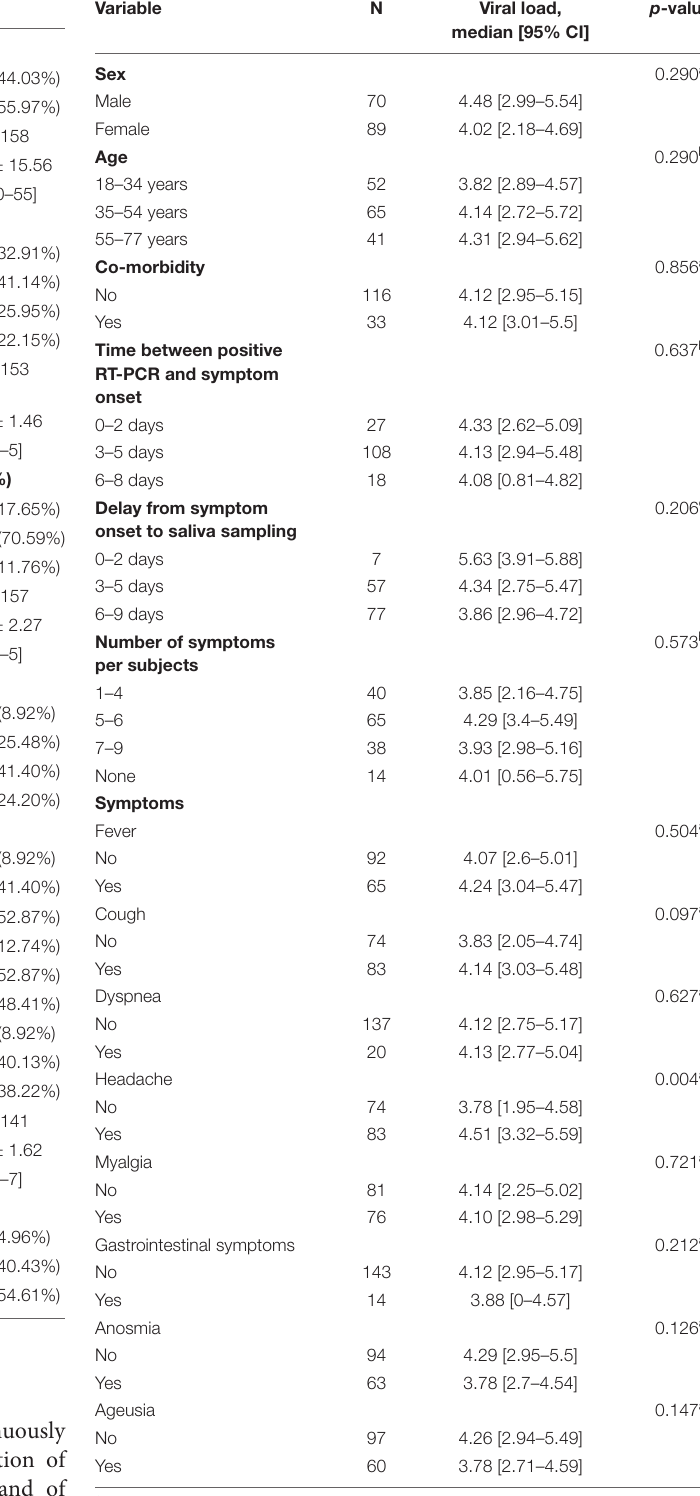
TABLE 3 | Association of viral Load with demographics and clinical parameters for all enrolled participants: N: number of